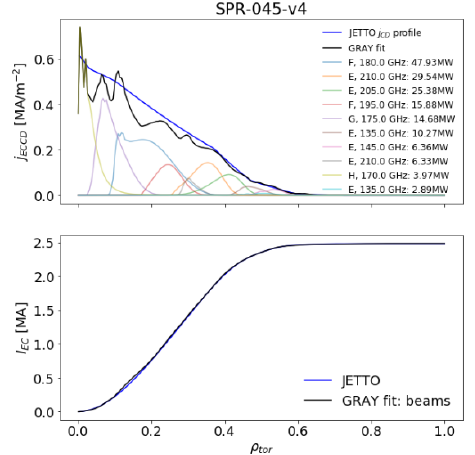
Fig. 4 : (a) The current density profile from integrated modelling (JETTO) and GRAY fit to that profile. (b) The cumulative integral of the current density for GRAY and